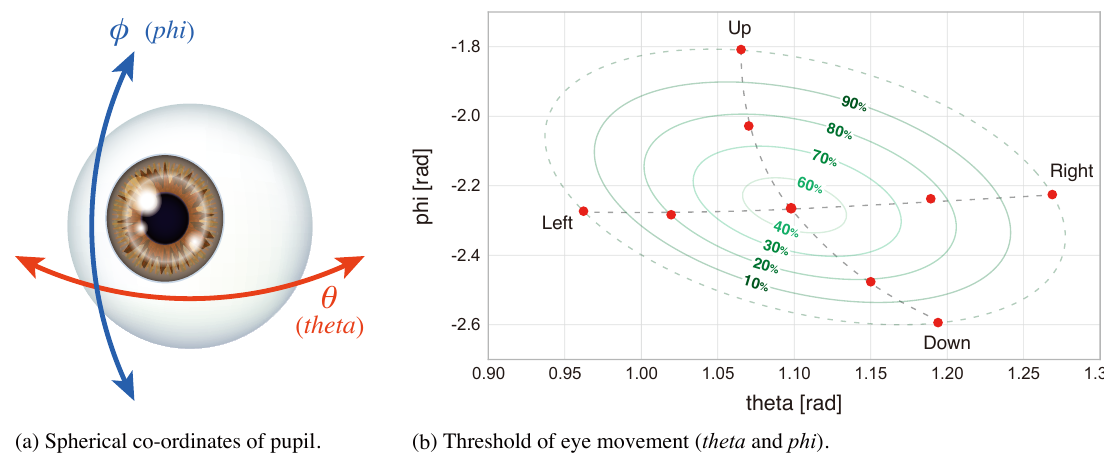
Figure 6. Representation of eye